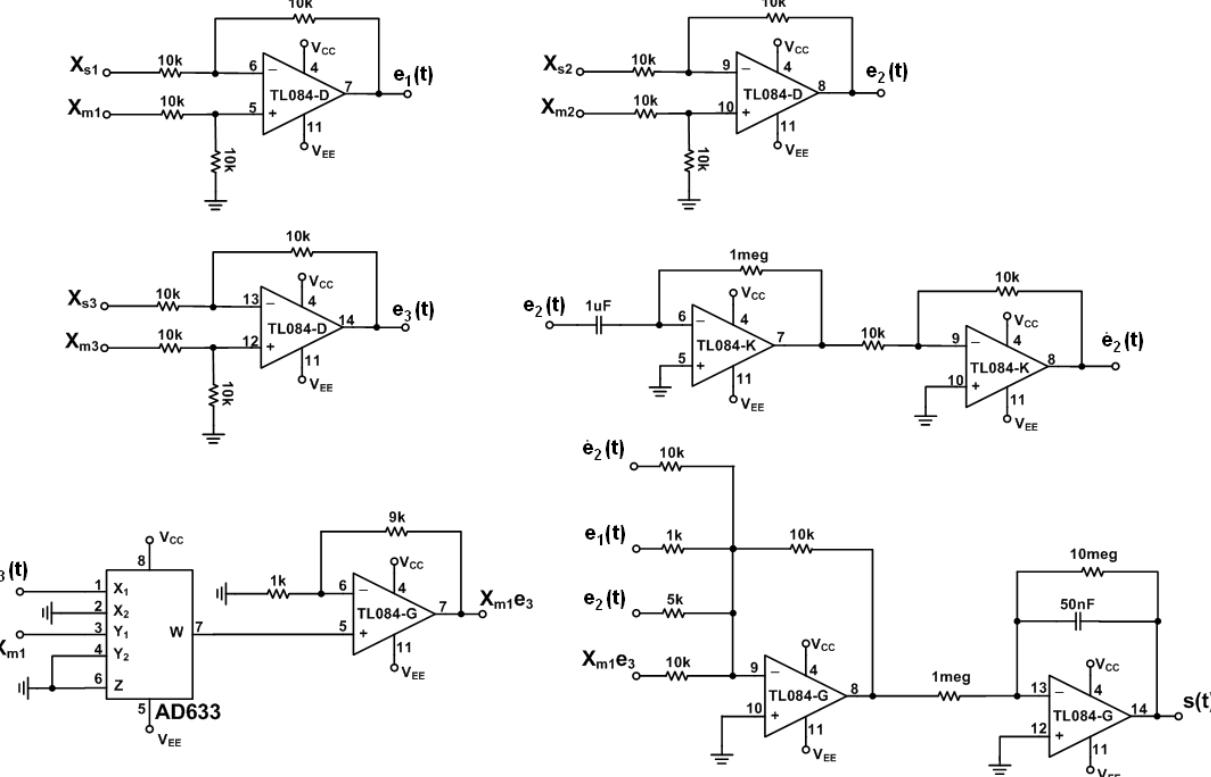
Figure 5. Electronic implementation of u